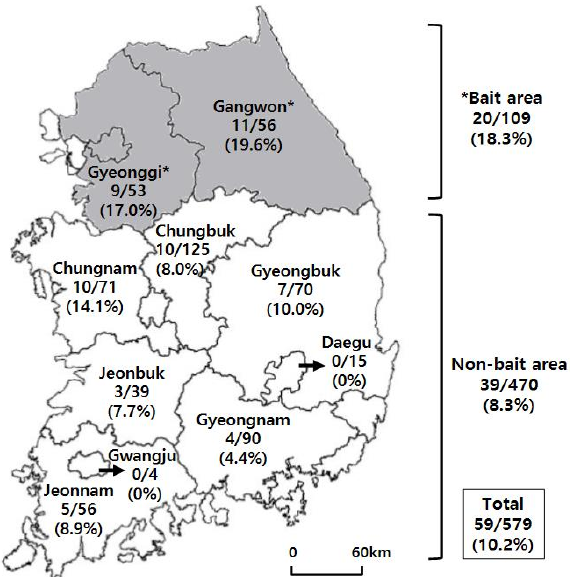
Figure 1. The number of wild boars (No. positive / No. total) and seropositive rate against rabies virus by region. The gray zones indicate the bait-vaccinated area (Seoul, Gangwon and Gyeonggi Provinces). Significant di ff erence was found between seropositive rates of bait-vaccinated and non-bait area ( p = 0.0042, Fisher’s exact